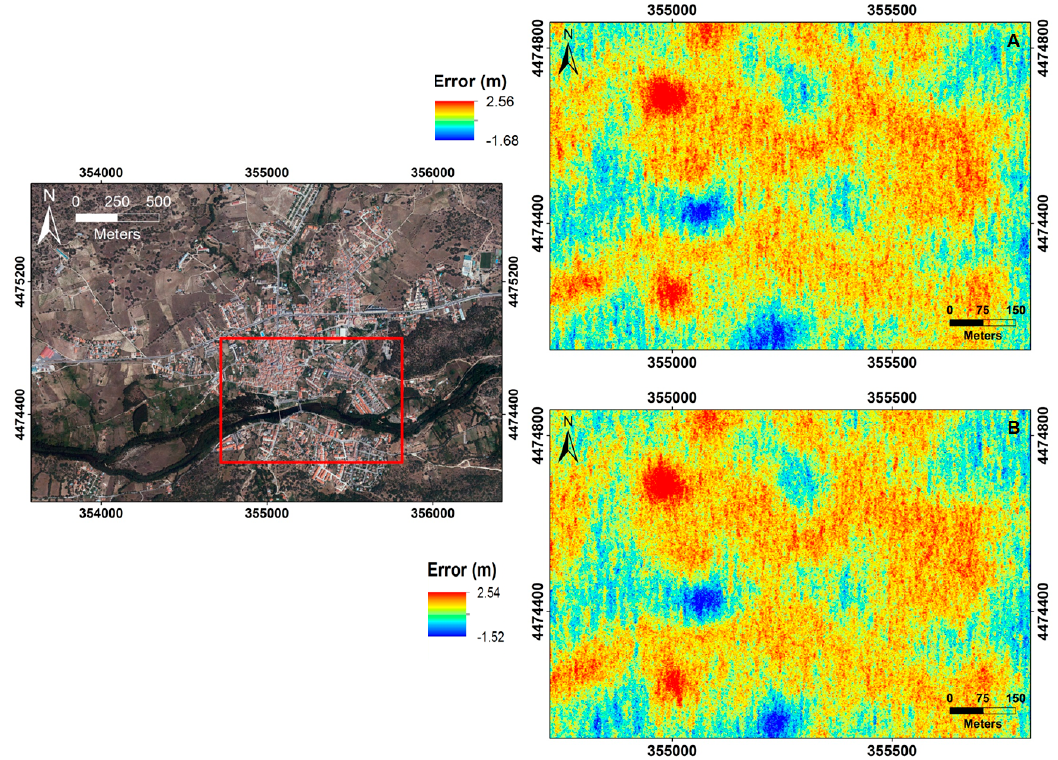
Figure 6. Two of the 1000 elevation error realizations generated using Sequential Gaussian Simulation. Each realization is equally probable and has the same statistical properties as the measured errors. The area and location of the simulations is outlined in red on the orthophoto. A corresponds to simulation 114 and B to simulation 772.